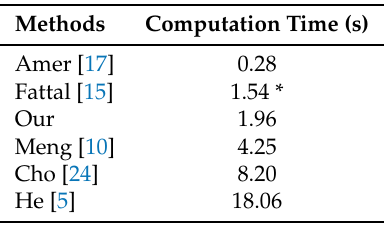
Table 3. Comparison of the computation time of our method against some methods of the literature on a 2.80 GHz machine and 620 × 460 resolution. (*) It was estimated relative to the reported running time of 5.4 s for 1 Megapixel by Fattal